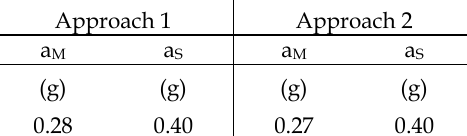
Table 3. Computed limit